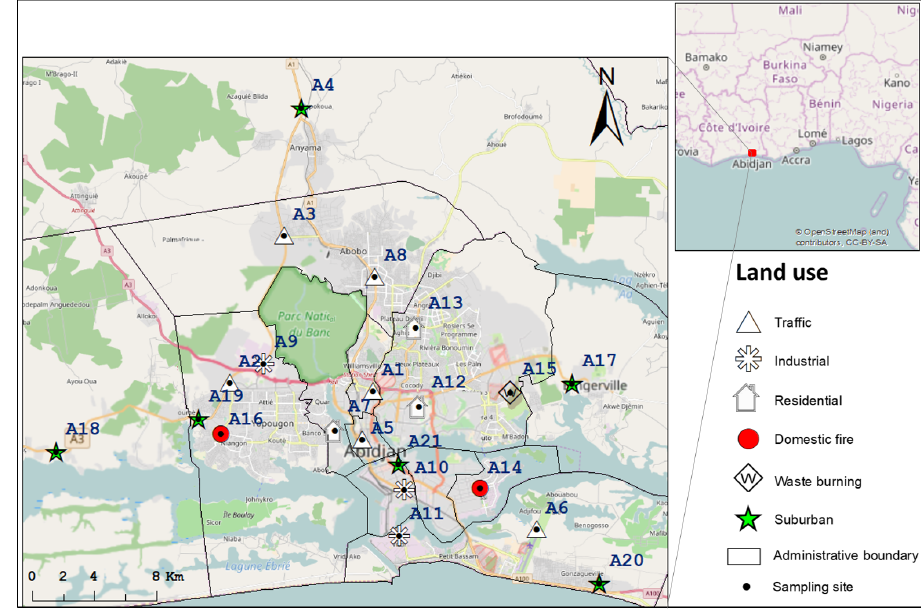
Figure 1. Spatial distribution of the 21 sampling sites (A 1 –A 21 ) and major sources of air pollution nearby in the district of